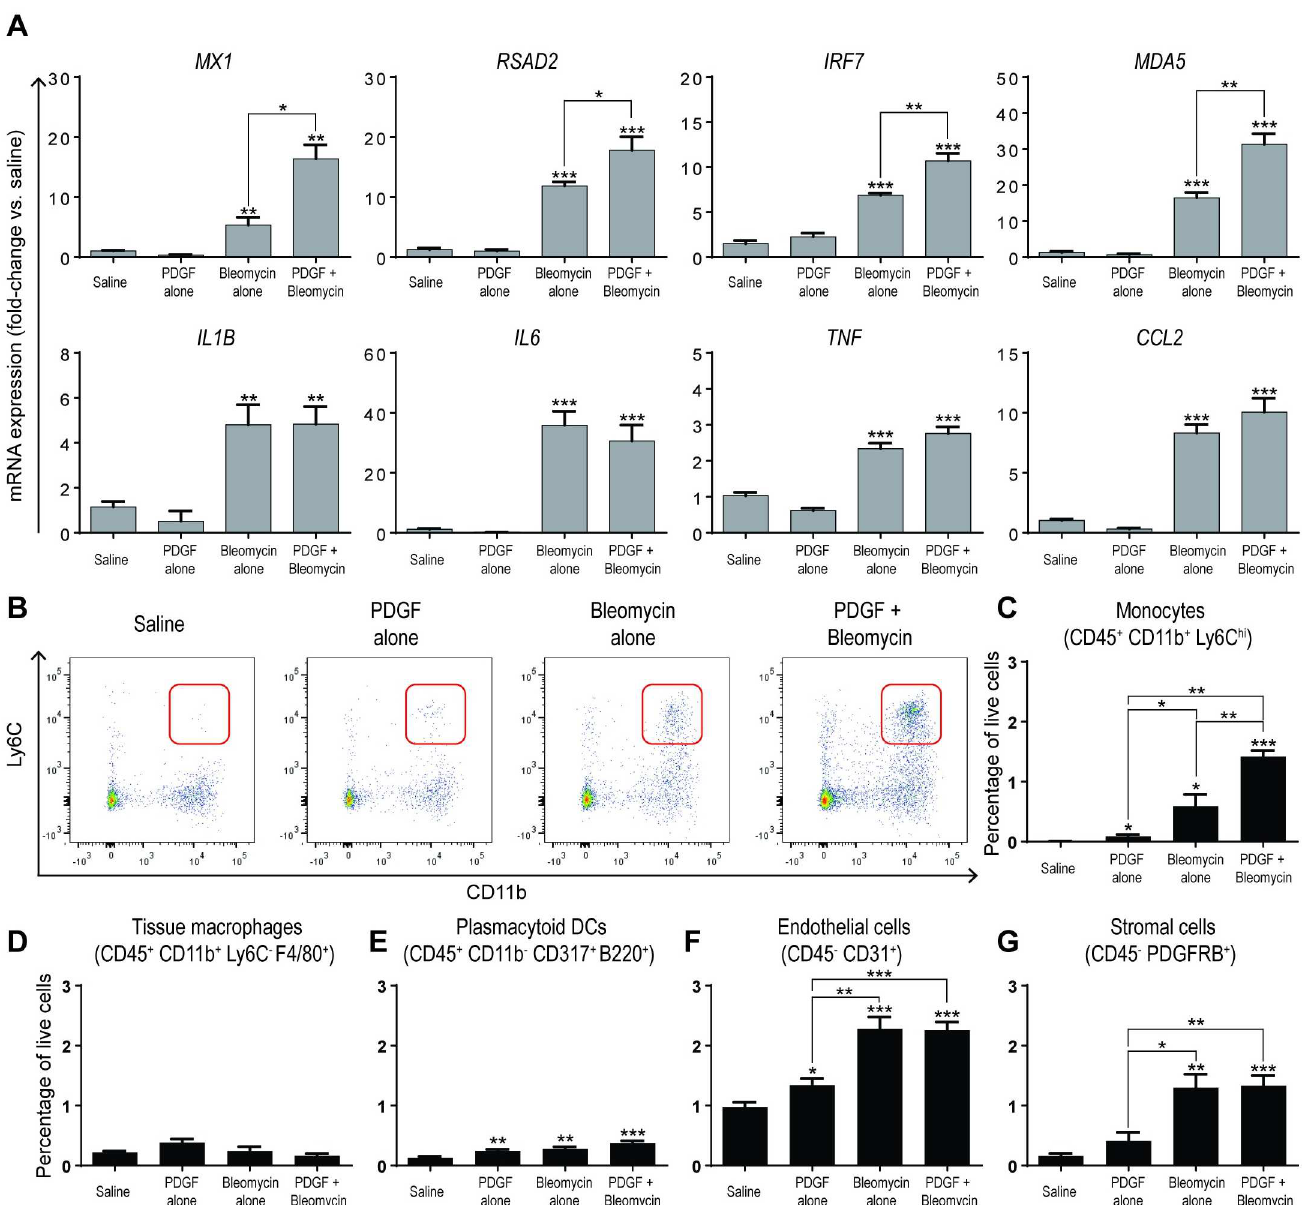
Fig 2. Inflammatory responseis skewed towards a Type I IFN-dependentresponsewithincreased recruitmentof monocytes. (A) Relative mRNA expression levels of the ISGs: MX1 , RSAD2 , IRF7 ,or MDA5 (top)or proinflammatorymediators: IL1B , IL6 , TNF , or CCL2 fromlesional skin homogenates of skin biopsiesperformed by Q-PCRon day 3. (B-G)Single-cellsuspensions of skin biopsiesobtainedfromtreatedmice and analyzed by flow cytometry. (B) Representative dot plot of totalCD45-postive leukocytes co-stained with CD11b and Ly6C. (C-G)Proportion of total live cells obtainedfromeach biopsy that stainedpositive for markersof: (C) monocytes (CD45 + CD11b + Ly6C hi ), (D) tissue residentmacrophages (CD45 + CD11b + F4/80 + Ly6C - ), (E) plasmacytoid dendritic cells (CD45 + CD11b - CD317 + B220 + ), (F)endothelialcells (CD45 - CD31 + ), or (G) stromalcells (CD45 - PDGFR β + ). Data is representative of at least two experiments with at least 5 mice/group/experiment. * P < 0.05, ** P < 0.01, *** P < 0.001, versus saline or between bracketed comparisons shown (student’s t test).